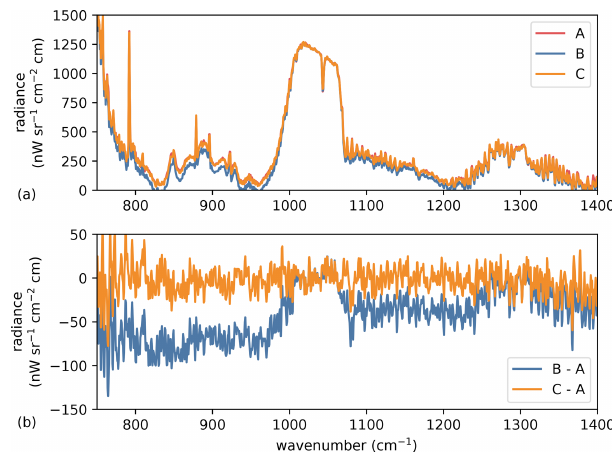
Figure 9. Panel (a) : spectra averaged over all pixels marked by black rectangles in Fig. 8. “A” refers to all pixels in the two outer rectangles in Fig. 8a, whereas “B” refers to all pixels within the center rectangle. “C” refers to all pixels in the center rectangle of Fig. 8b. (The “A” and “C” spectra are very similar.) Panel (b) high- lights the differences between the spectra shown in panel (a)